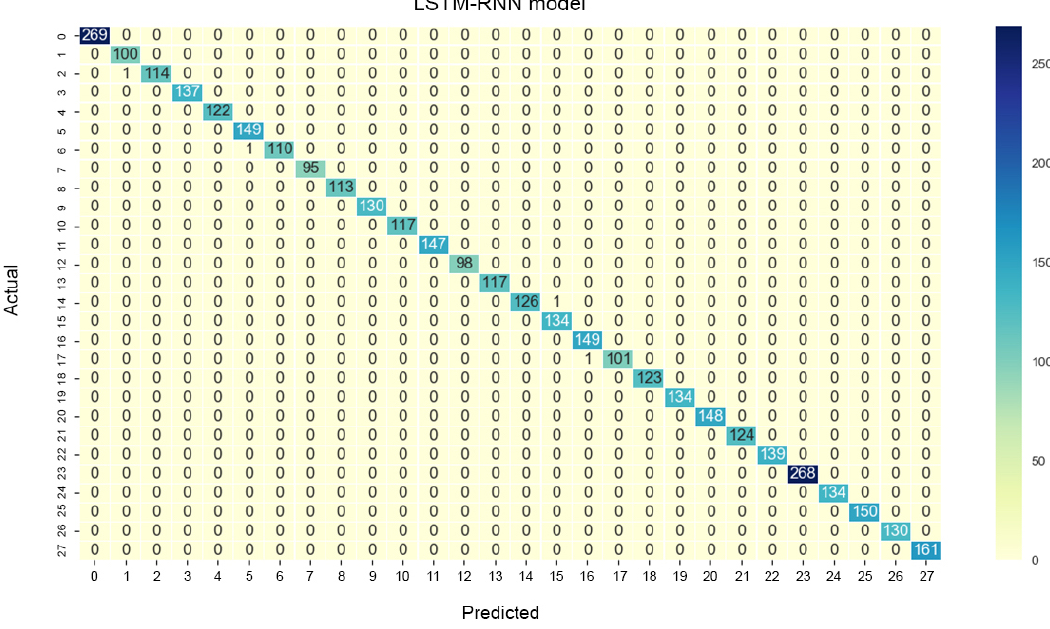
Figure 6. Confusion matrix of the trained RNN